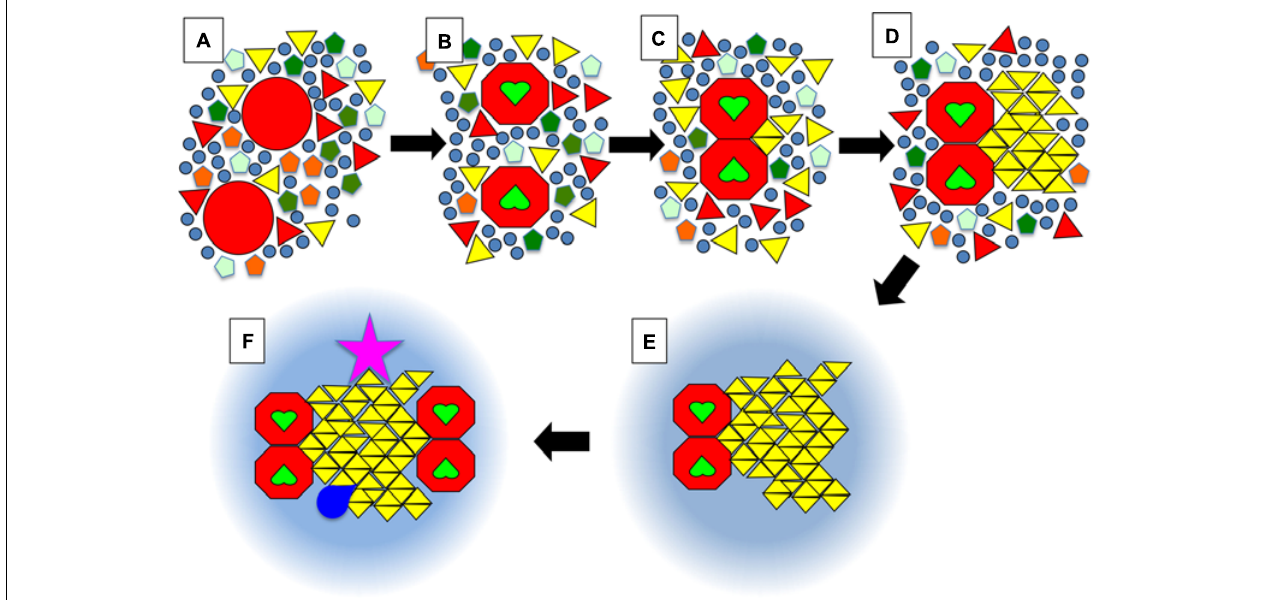
membrane dock, with the crystalline mesh dictating the specificity for one (or quite probably several) type(s) of lipid(s) with particular head groups and acyl chains, e.g., certain gangliosides (in the outer leaflet), phosphatidilinositol phosphates (PIPs) or even phosphatidic acid (PA) (in the inner leaflet). (E) After a crystalline dock forms, it will be surrounded by a ring of lipids with intermediate properties between So and Lo, which will most likely be quite similar to what is usually defined as rafts, i.e., enriched in sphingolipids and cholesterol. (F) Via percolation and enlarge- ment of the catchment area, the rings could favor the exclusion or recruitment of other activated receptors, or of cofactors (kinases, GTPases ... ; dark blue shape). Importantly, some components of the dock (pink star) might be anchored to the cytoskeleton on the cytosolic side, or on the exoplasmic side to the extra-cellular matrix in mammalian organisms, or to the cell wall in plants and